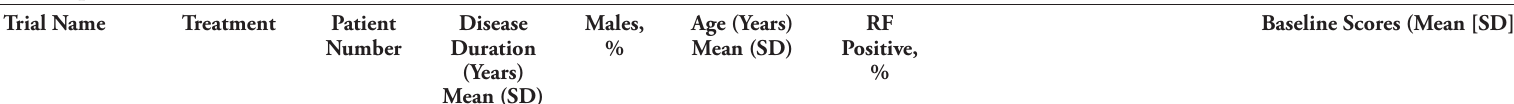
Table 1. Population characteristics: MTX-IR,